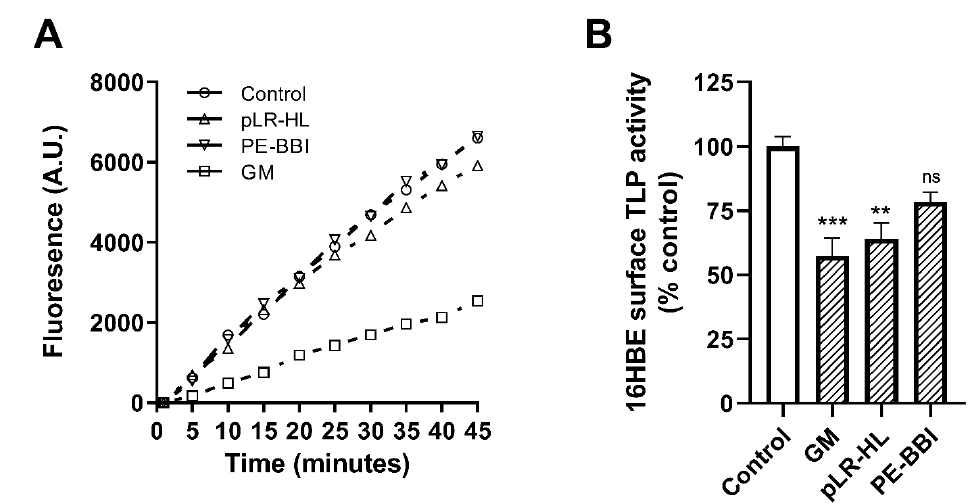
Figure 2. Evaluation of protease inhibitors compounds on polarised 16HBE surface TLP activity. ( A ) Typical kinetic trace demonstrating TLP cell surface protease activity in the presence or absence of putative inhibitor compounds. Summary data are quantified in panel ( B ). Data are presented as the mean ± SEMs (n = 7). ** P < 0.01, *** P < 0.001, ns (not significant).